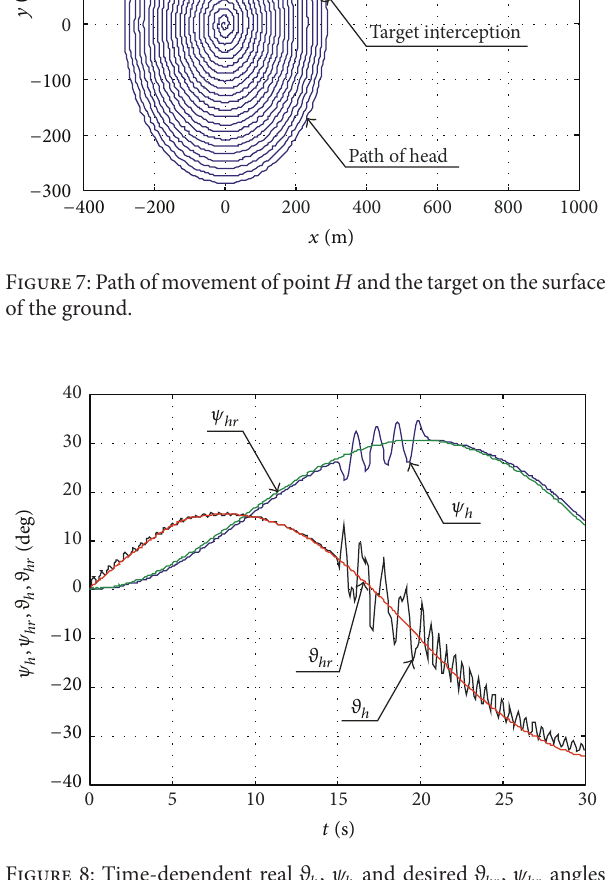
Figure 8: Time-dependent real 𝜗 ℎ , 𝜓 ℎ and desired 𝜗 ℎ𝑟 , 𝜓 ℎ𝑟 angles specifying the location of the head axis for nonoptimum controls with the influence of disturbances.